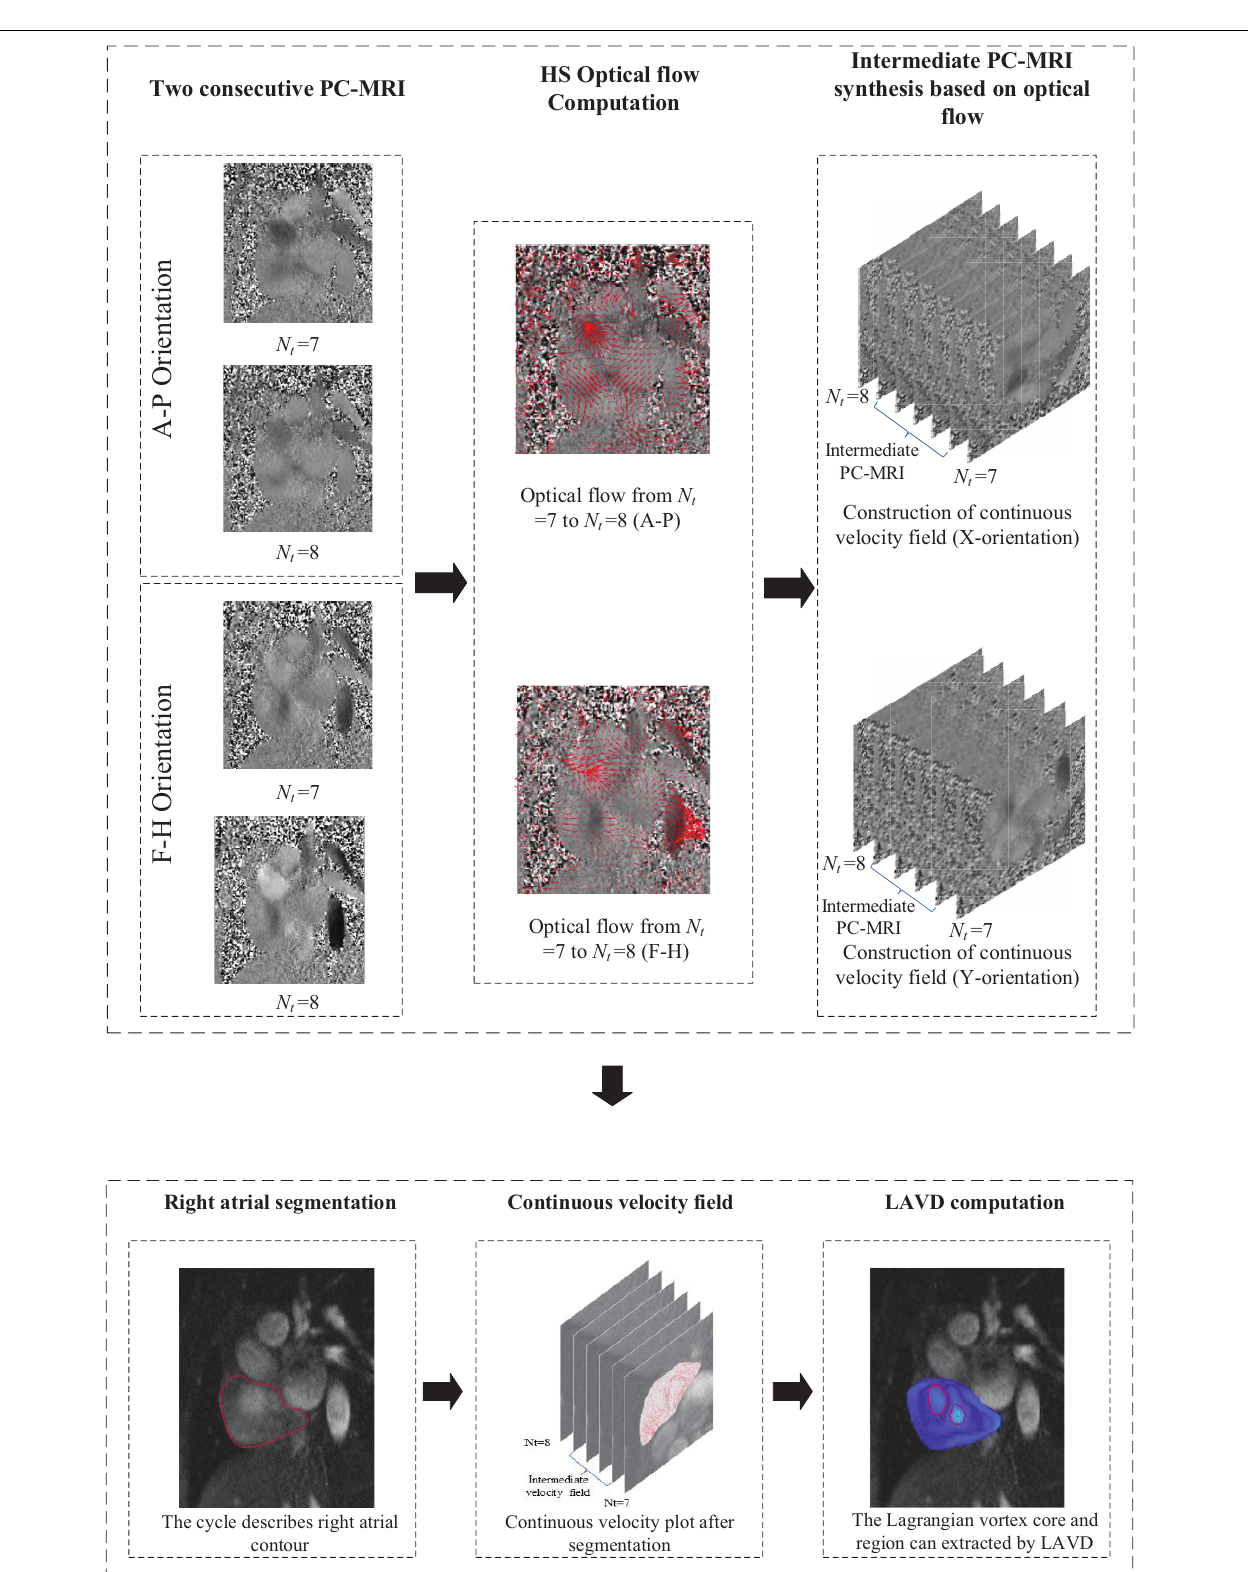
FIGURE 2 | The pipeline of the proposed Optical flow-LAVD based identification of Lagrangian vortex ring.